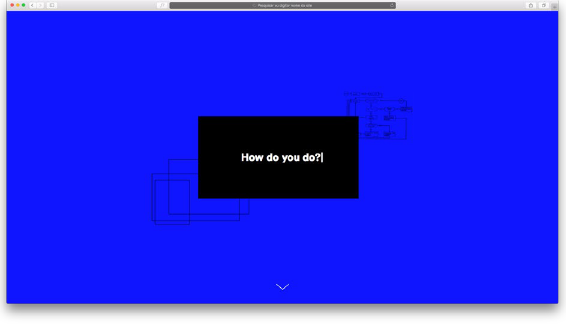
Figure 1 | Conversations with ELIZA website.